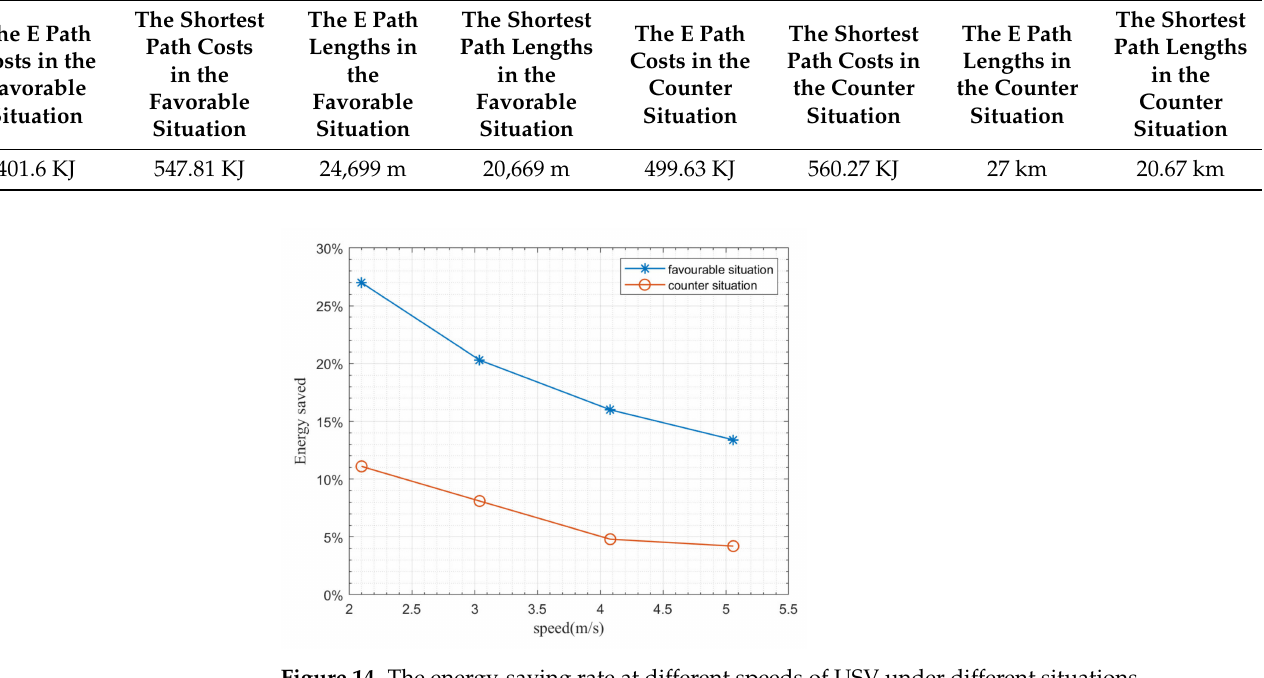
Figure 14. The energy-saving rate at different speeds of USV under different